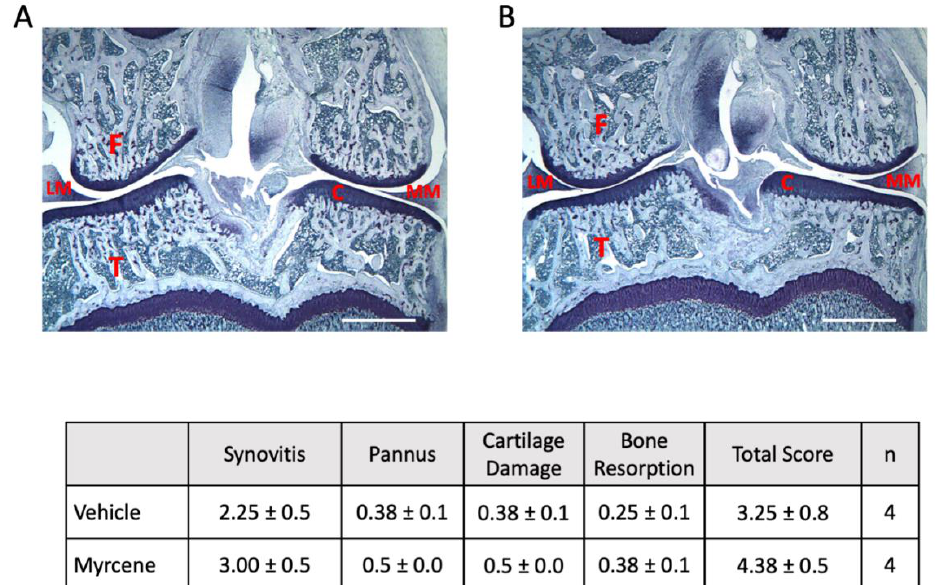
Figure 6. Lack of effect of chronic myrcene treatment on joint histopathology. Representative histological sections of day 21 adjuvant monoarthritic knees (frontal plane) following repeated administration of either vehicle ( A ) or myrcene ( B ). Table shows that myrcene had no effect on the joint damage scores across the four parameters. C: joint cartilage; F: femur; LM: lateral meniscus; MM: medial meniscus; T: tibia. Scale bar = 2.5 mm.